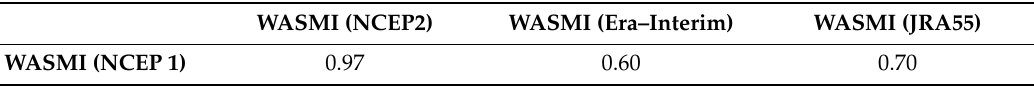
Table 2. Correlation coe ffi cient values between WASMI generated from the NCEP1 reanalysis and those generated from other data